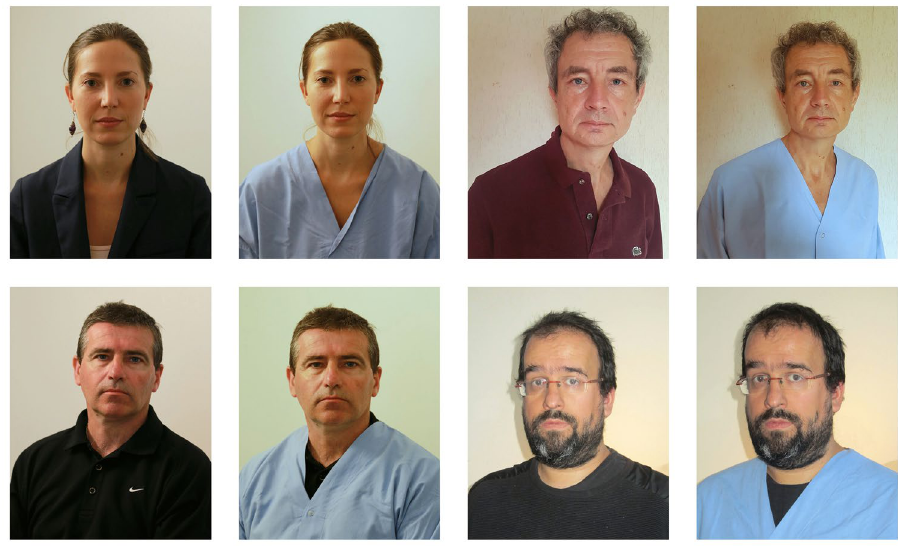
Figure 1. Four members of the team in pyjamas and in day